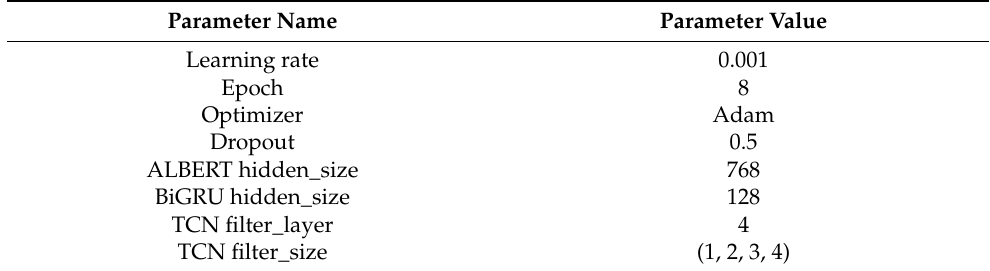
Table 2. Setting up the model